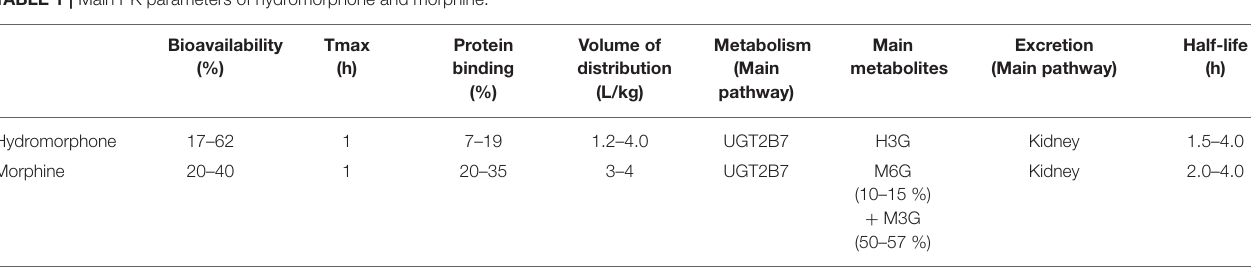
TABLE 1 | Main PK parameters of hydromorphone and